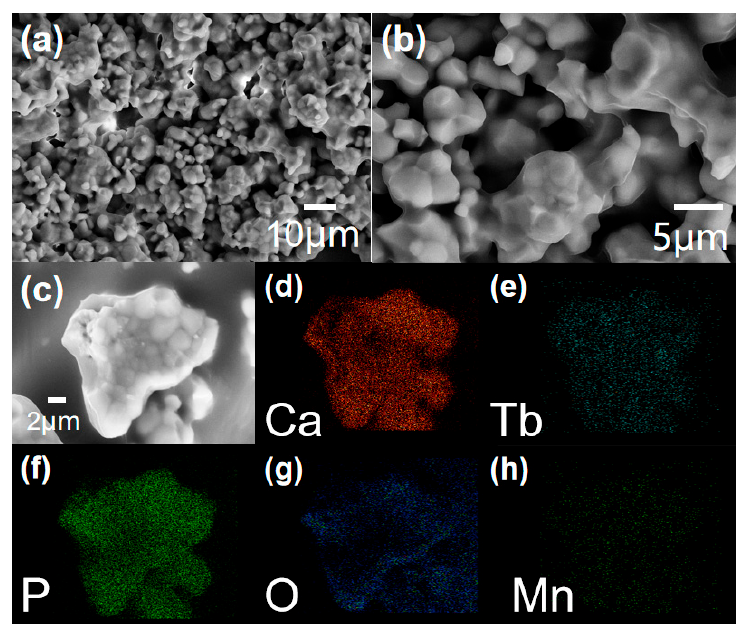
Figure 2. CTP:0.3Mn 2+ phosphor SEM image of ( a ) 10 μ m multiplying power, ( b ) 5 μ m multiplying power, ( c ) 2 µ m multiplying power, and EDS mapping of element, ( d ) Ca, ( e ) Tb, ( f ) P, ( g ) O, ( h ) Mn.